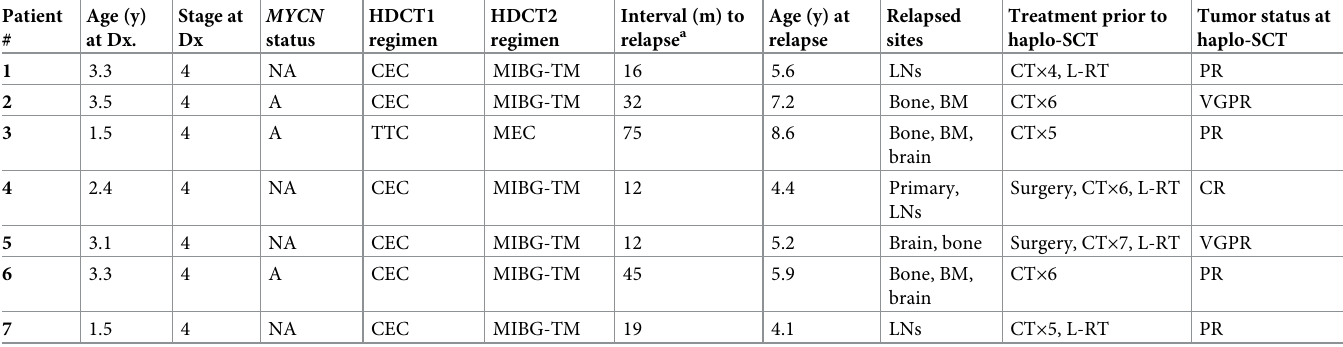
Table 1. Patient characteristics. Age (y) at Dx.